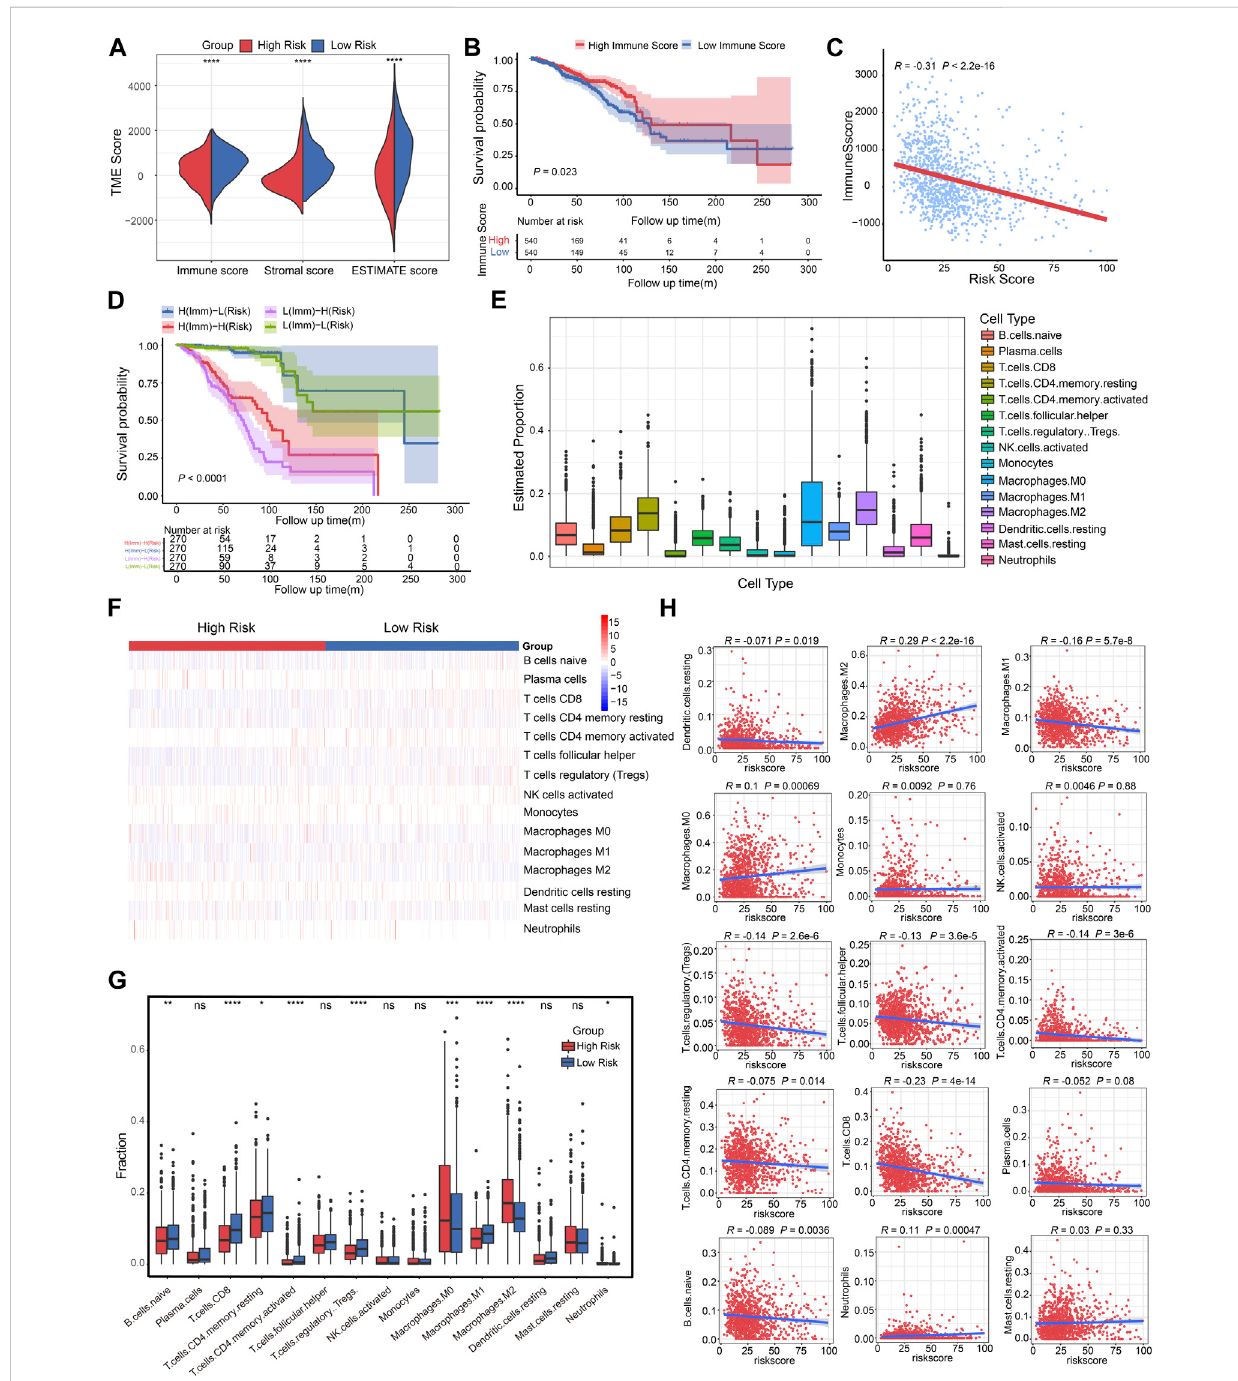
FIGURE 5 Correlation analysis of CSRGs risk score, immune score and immune cell in fi ltration in BRCA. (A) Violin plot illustrated the association between risk score and both immune and stromal scores in TME. (B) The Kaplan-Meier analysis was utilized to evaluate the OS between the low-immune and high- immune groups in BRCA patients. (C) The relationship between the immune score and risk score was displayed by box plot. (D) Kaplan-Meier survival analysis showed the OS among four patient groups strati fi ed by both immune score and CSRGs risk score. (E) Box plots described the estimated proportionof15in fi ltrativeimmunecellsinTME. (F) Heatmapofthe15in fi ltrativeimmunecellsforpatientsinhigh-riskandlow-riskscoregroups. (G) Box plotsillustratedthedifferentimmunecell proportionsintworiskscore groups. (H) Scatterdiagramshowedthelinearrelationship betweenriskscore and in fi ltrative immune cell types. * p < 0.05; ** p < 0.01; *** p < 0.001; **** p < 0.0001; NS, not signi fi